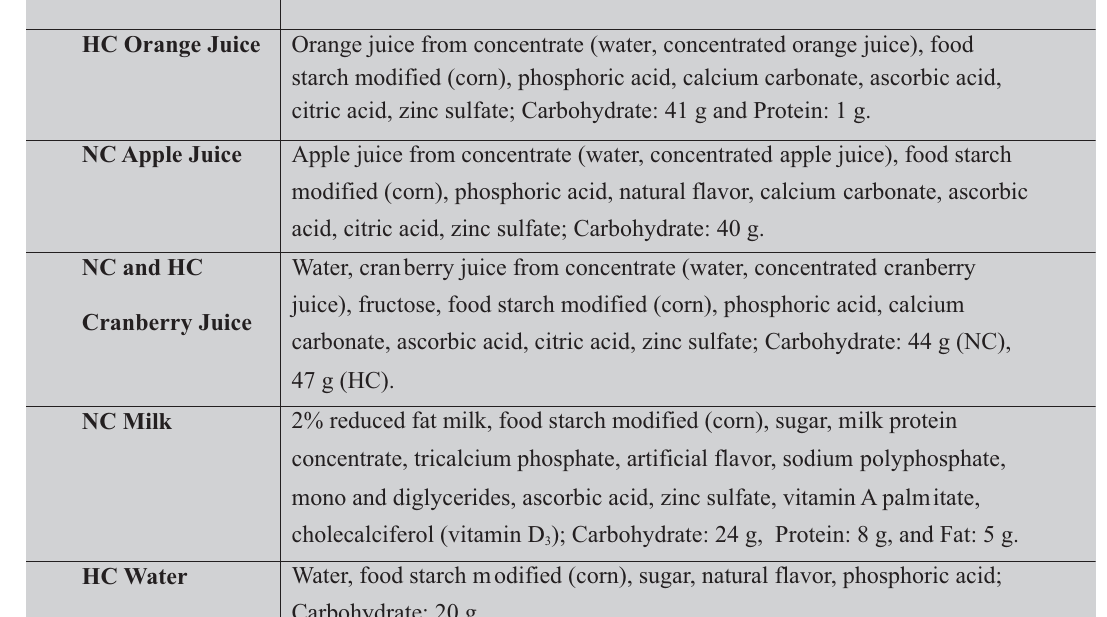
Table 1: Constituents of the pre- thickened foods